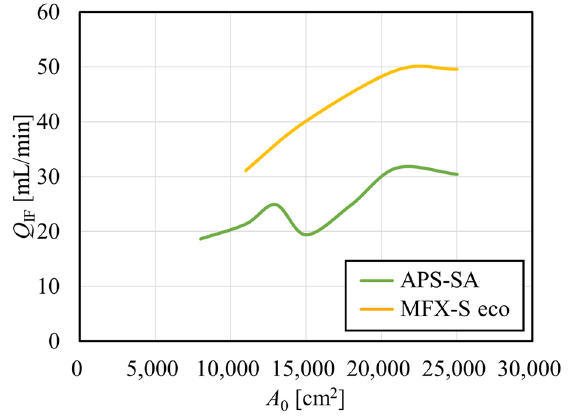
Figure 6. Relationship between the arithmetic surface area and the internal filtration flow rate calculated from pressure distribution.